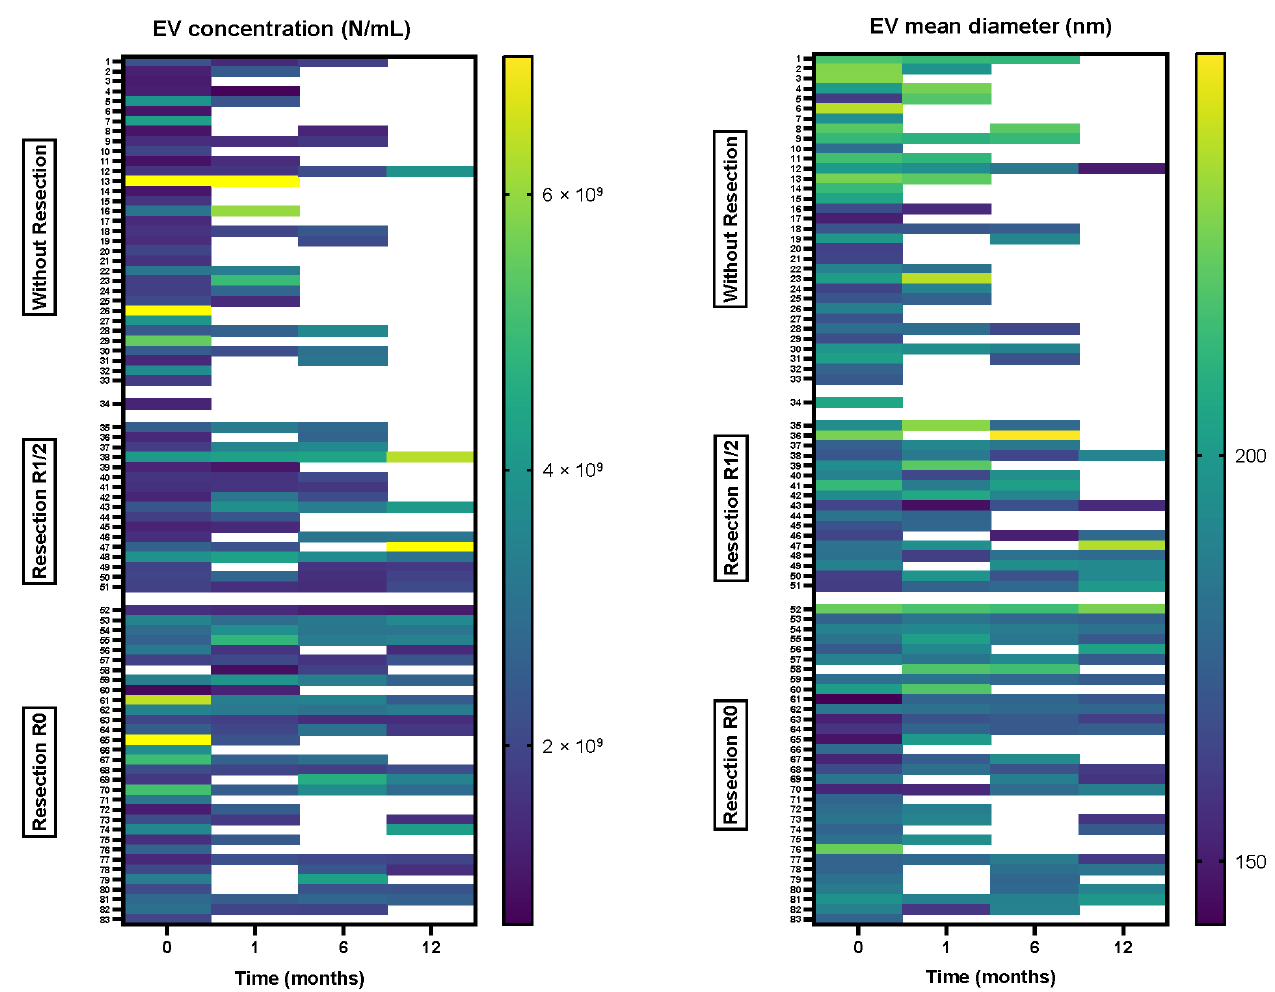
Figure 1. Heatmaps comparing sEV concentration ( left ) and mean size ( right ) for PDAC patients at different time points during follow-up. Patients were grouped according to type and radicality of surgery. Values outside the defined range are presented in yellow. Samples unavailable due to losing patients during follow-up are indicated in white.